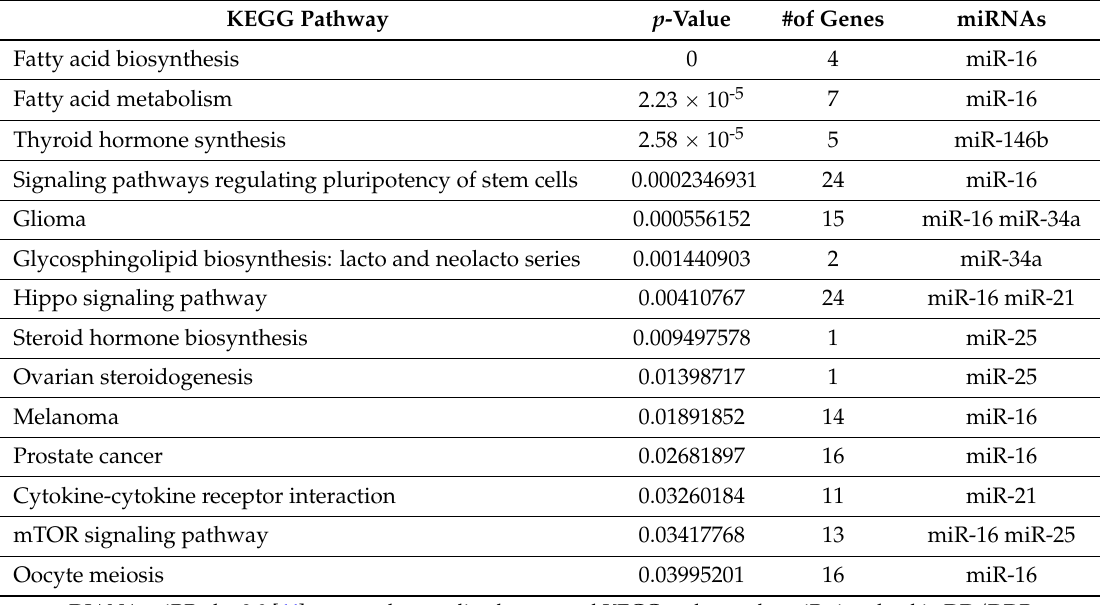
Table 3. Enriched KEGG pathways for predicted targets of the DD/DDR microRNAs modulated by all four compounds.